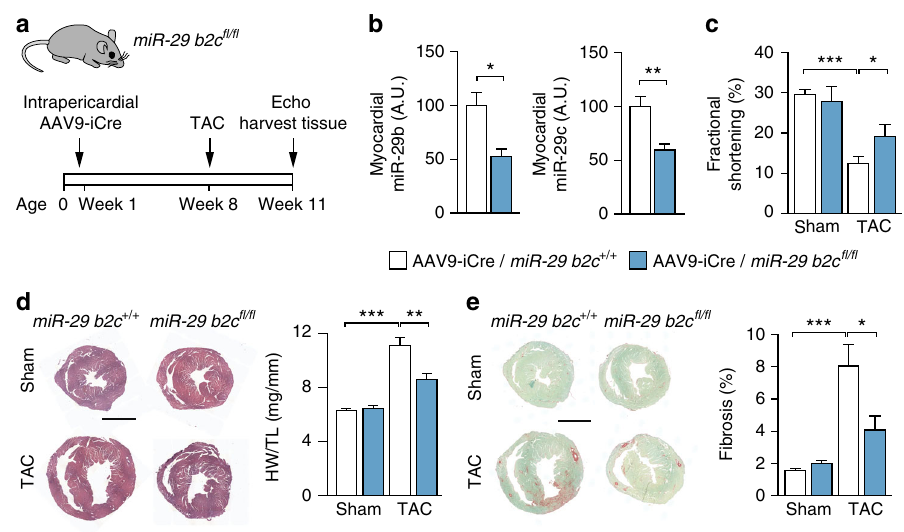
Fig. 4 Deletion of miR-29 in cardiac myocytes in vivo protects from cardiac remodeling. Tropism of adeno-associated virus 9 for cardiac myocytes in vivo was employed to deliver improved Cre recombinase (AAV9-iCre) to miR-29 b2c fl / fl mice for the deletion of this cluster (with miR-29 b2c + / + littermates serving as controls). a Design of the study. 5 × 10 11 viral particles (AAV9-iCre) were delivered to 5 day-old mice via intrapericardial injection. Seven weeks later, mice were subjected to TAC or sham surgery and sacri fi ced another 3 weeks later (after echocardiographic analysis). b Expression of miR-29b and miR-29c in cardiac tissue from mice treated as in a ; n = 4 – 6 mice per group. c Left ventricular fractional shortening as determined by echocardiographic analysis; n = 4 – 8 mice per group. d (Left) Representative hematoxylin eosin stainings of myocardial sections; scale bar = 2 mm. (Right) Heart weight-to- tibia length ratio; n = 4 – 11 mice per group. e (Left) Representative myocardial sections stained for fi brosis with Sirius Red/Fast Green and (right) quantitative analysis of the results; n = 4 – 9 mice per group; scale bar: 2 mm. All quantitative data are reported as means ± SEM. * P < 0.05, ** P < 0.01, *** P < 0.001 as determined by Student ’ s t -test b or two-way ANOVA followed by Bonferroni ’ s post hoc test c –